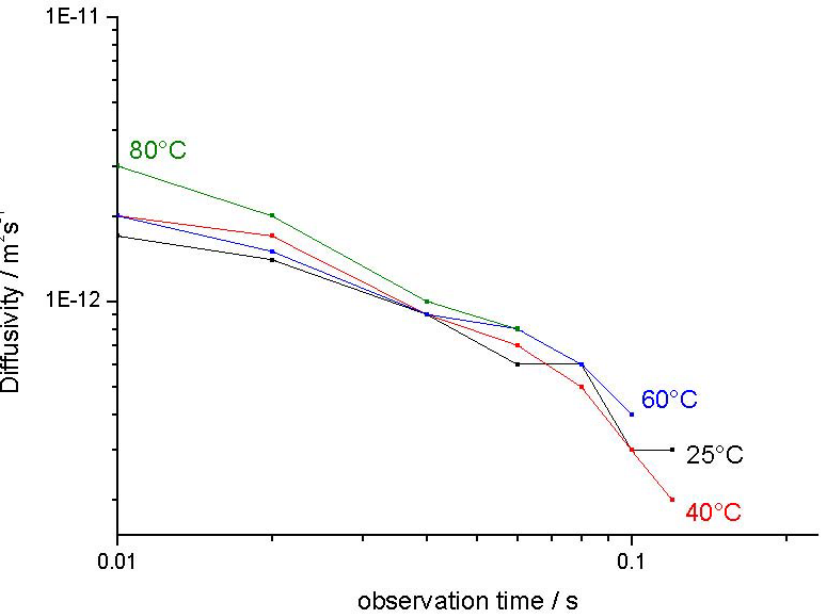
Figure 11. Order-of-magnitude estimate of the effective diffusivity of propane in NaCa-LTA-2 as resulting from the second slowly decaying part in the attenuation curves in Figures 8 and